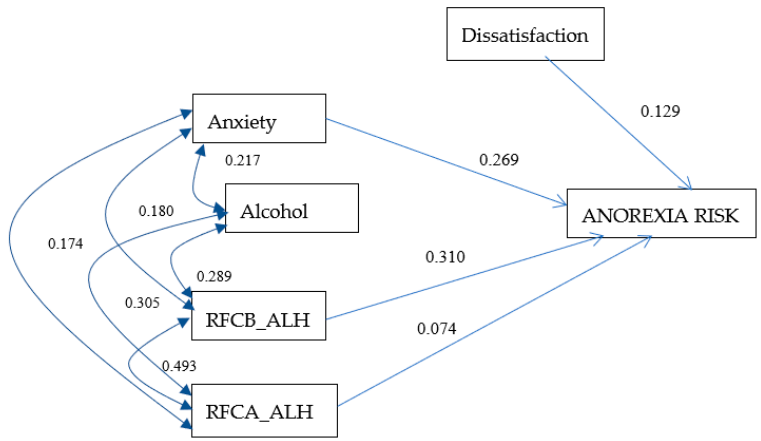
Figure 2. Anorexia risk model for women. The values on one-headed arrows are the standardized regression weights and those on each two-headed arrow are the correlations for the model. The shapes in the diagram are defined as follows: small ovals are measurement or prediction errors; rectangles, measured variables. RFCB_ALH: food restriction before consuming alcohol. RFCA_ALH: food restriction after consuming alcohol. X 2 = 5.34, p = 0.376, CFI = 0.998, PNFI = 0.325, RMSEA = 0.016, and R 2 = 0.250.